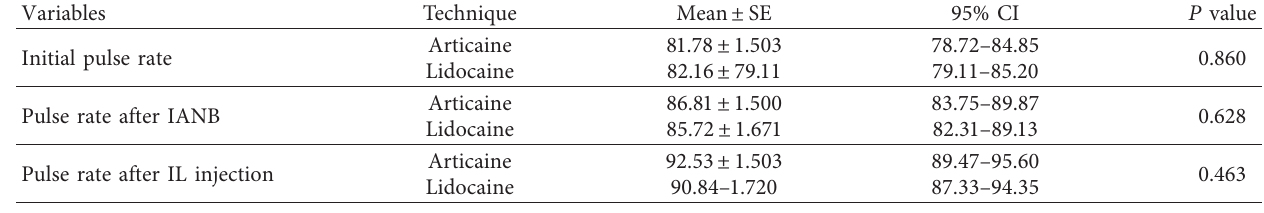
Table 3: Mean pulse rates before and after inferior alveolar nerve block and intraligamentary injections with articaine and lidocaine. Variables